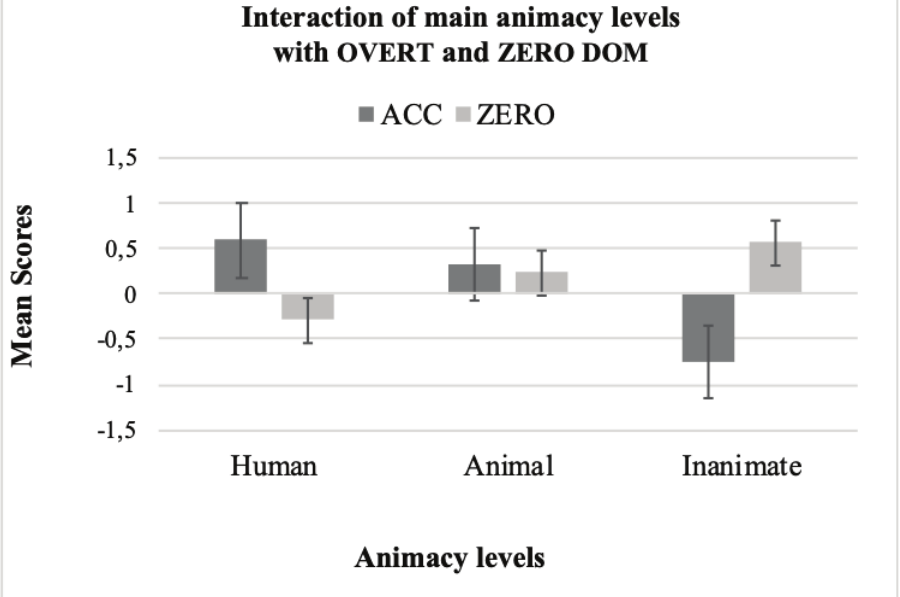
Fig ure 3. Acceptability of sentences with indefinite direct objects belonging to different animacy levels with overt and zero DOM used in transparent context. Error bars represent +/- 2 standard errors